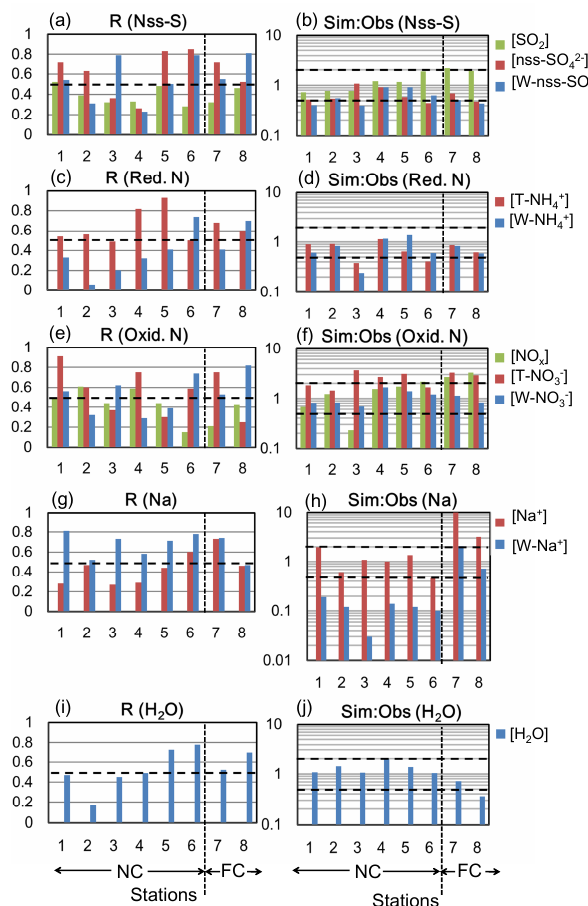
Fig. 7. Comparison of statistical results at the eight EANET sta- tions (1. Rishiri, 2. Tappi, 3. Ogasawara, 4. Sado, 5. Oki, 6. Hedo, 7. Happo, and 8. Yusuhara). R and Sim : Obs, for gas, aerosol and precipitation of anthropogenic sulfur oxides (nss-S, a, b ), reduced nitrogen (Red. N, c, d ), oxidized nitrogen (Oxid. N, e, f ), sodium (Na, g, h ), and amounts of precipitation (H 2 O, i, j ). Dashed lines indicate (left) R of 0.5 and (right) the factor-of-2